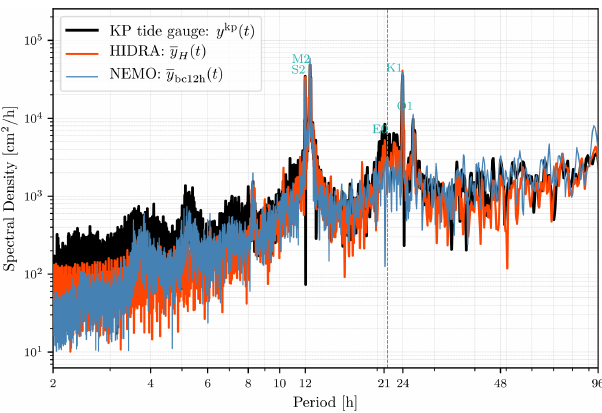
Figure 10. Power spectrum of NEMO y bc12h (t) ensemble forecast mean time series (blue line), HIDRA ensemble forecast mean time series y H (t) (orange line) and tide gauge observations time series y kp (t) (black line) for year 2019. Turquoise symbols denote spec- tral peaks due to respective tidal constituent. E 0 denotes the spec- tral peak due to fundamental Adriatic seiche with a period of 21.5h, also marked with the vertical turquoise dotted